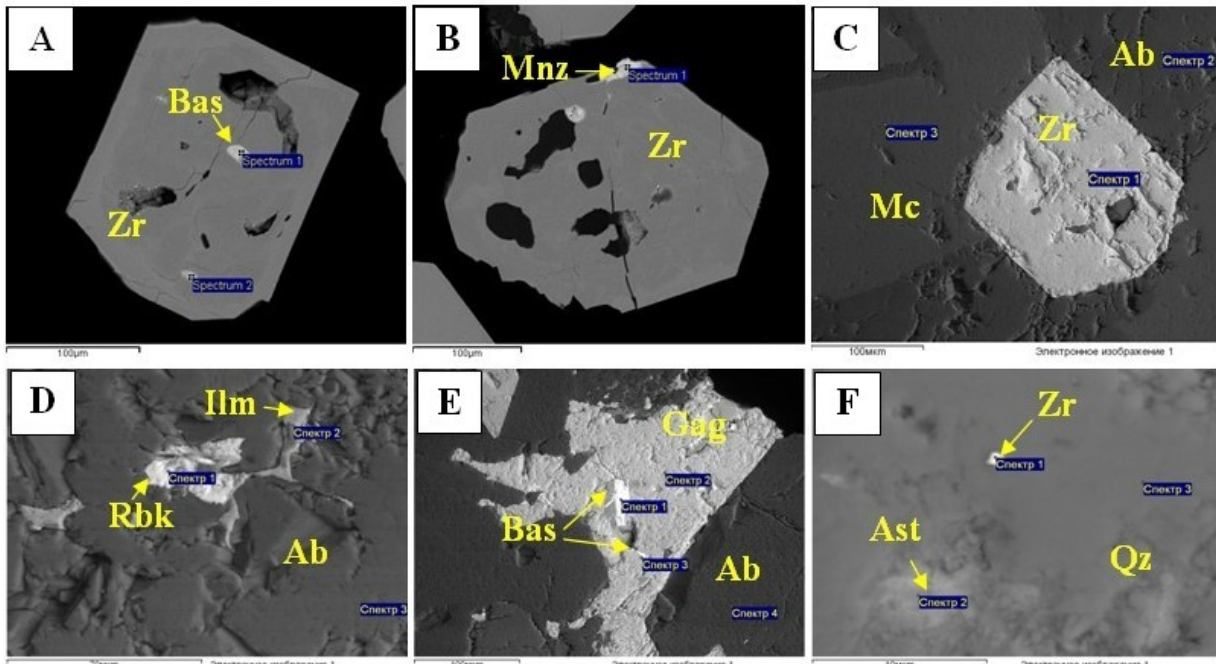
Figure 13. Microinclusions of REE minerals in the Espe granites, Verkhnee Espe rare-element deposit. Scanning electron microscope images (JSM 6390LV), analyst A. Sadibekov. ( A ) Bastnaesite microinclusions in zircon; ( B ) monazite inclusions in zircon; ( C ) zircon grain at contact with albite and microcline; ( D ) riebekite and ilmenite inclusions in albite; ( E ) gagarinite in albite and bastnaesite in gagarinite; ( F ) astrophyllite microinclusions in quartz, with gold in astrophyllite.